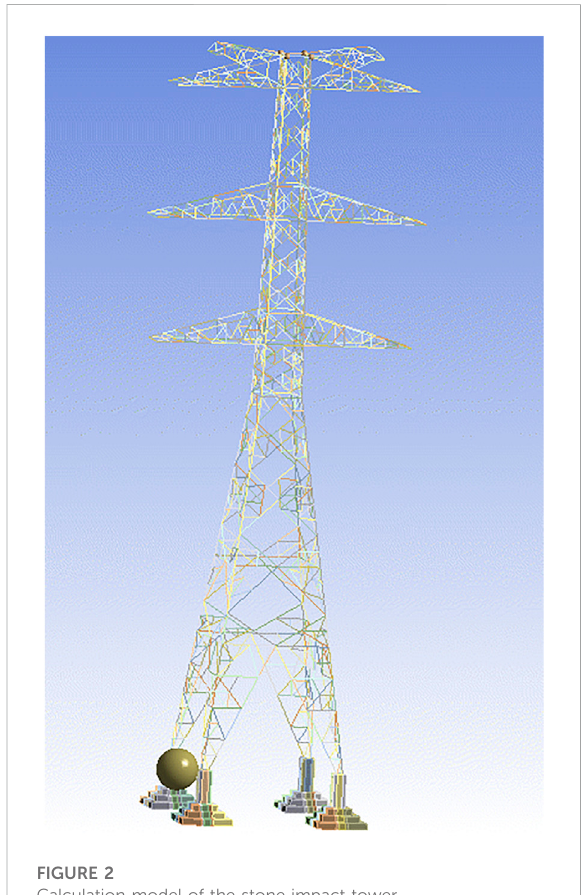
FIGURE 2 Calculation model of the stone impact